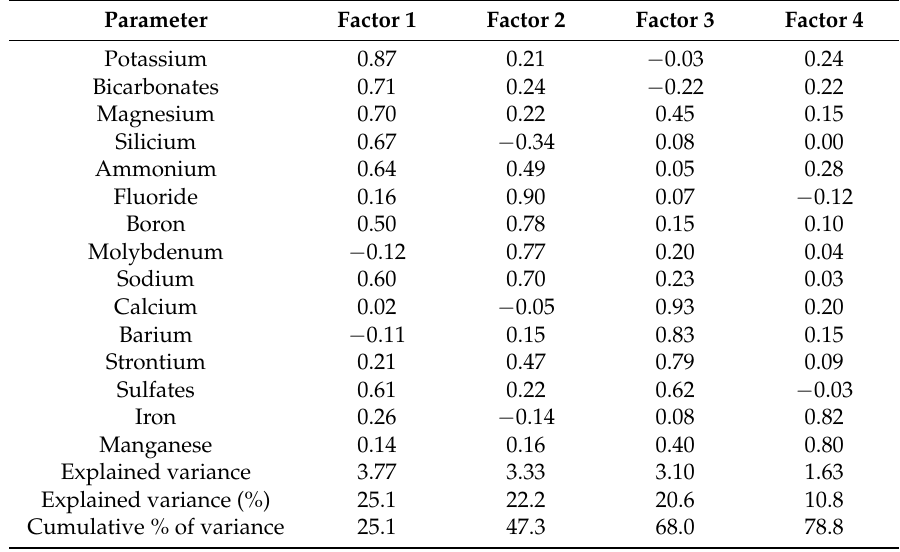
Table 6. Factor analysis loadings and explained variance after applying a Varimax